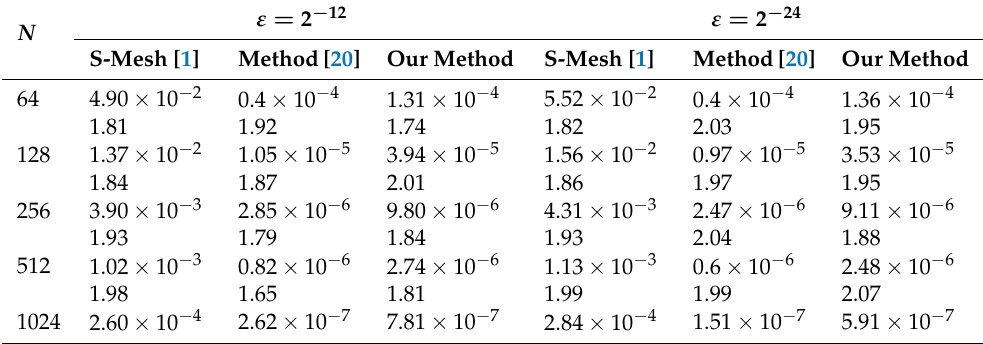
Table 2. Comparison of numerical results with the other methods for Example